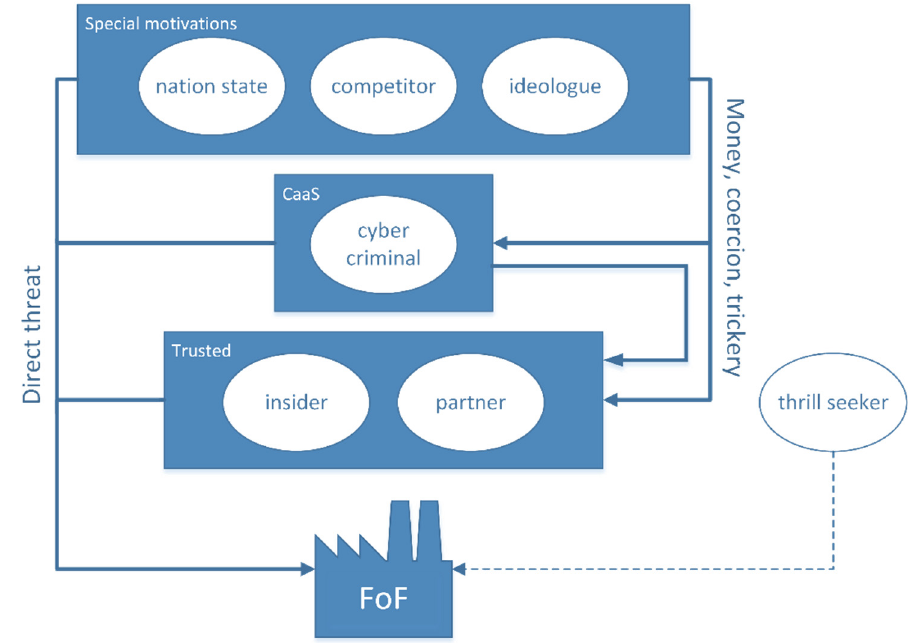
Figure 3. The threat hierarchy. Cyber threat actors (CTAs) at the top of the hierarchy use other actors as threat vectors. Criminals can be hired (cyber crime as a service (CCaaS)), and trusted actors can be bribed, coerced or deceived. Thrill seekers pose only a minor threat to the factory of the future (FoF) environment.